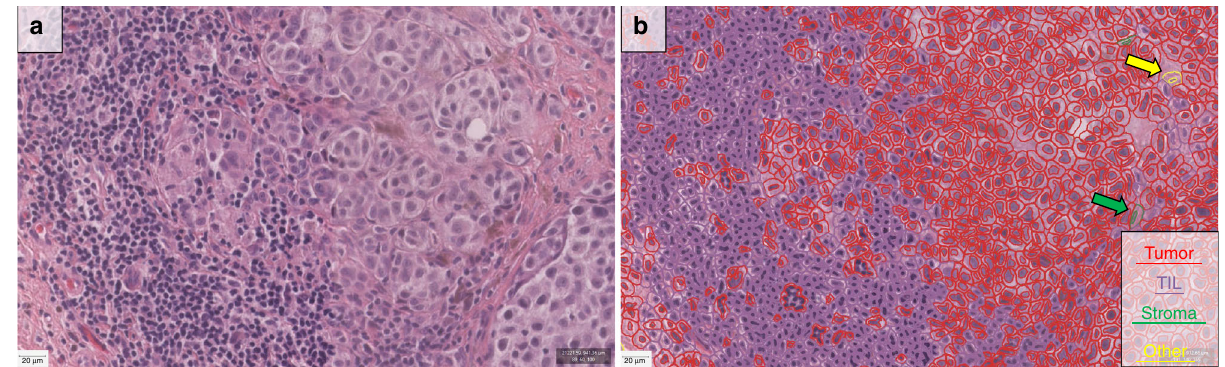
Fig. 3 Representative picture of a sample melanoma case showing the H&E image (Zoom: ×20, a ) and the digital-image analysis (DIA) mask ( b ). Scale bar represents 20 µ m. Using the NN192 algorithm, segmentation shows red indicates tumor cells, purple marks immune cells, green corresponds to stromal cells, and yellow indicate others (false cell detections or unknown or background). Since stromal and “ other ” cells are rare, large arrows are included to show example